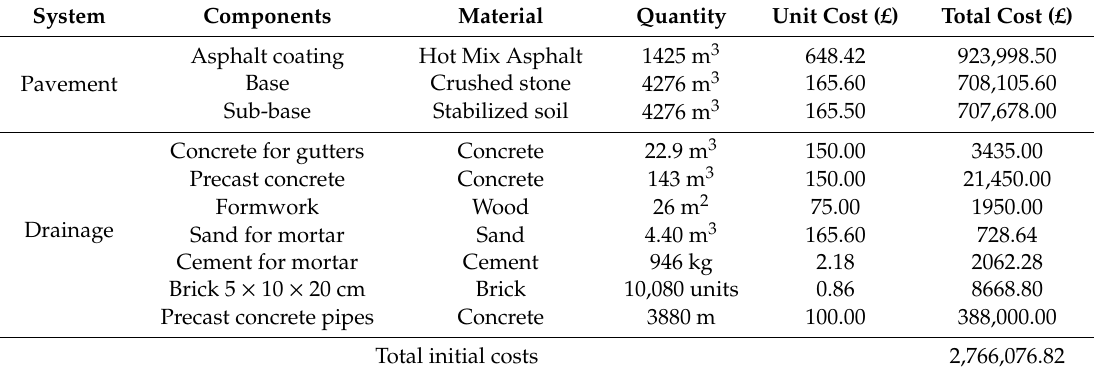
Table 4. Initial cost for a traditional (impermeable) pavement with a conventional drainage system.